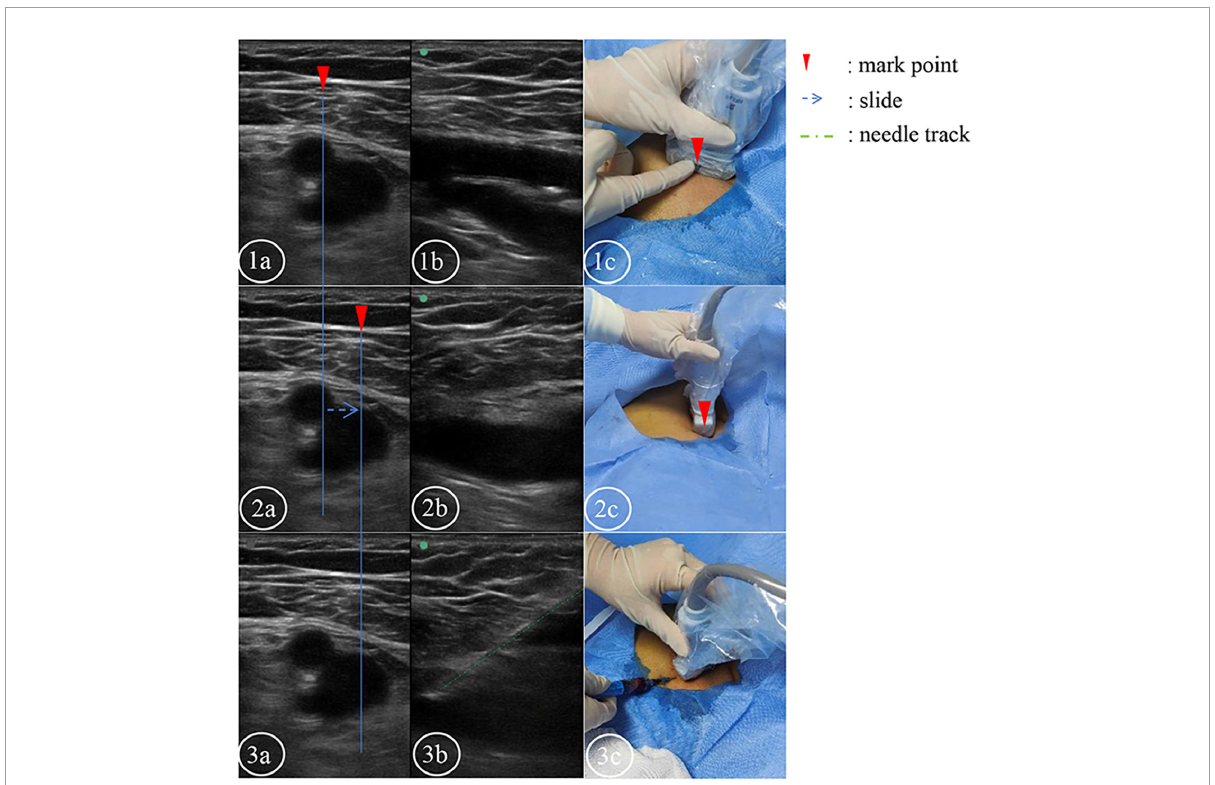
FIGURE1 The short and long axis double screens were used to control the puncture plane. (1–3a) Short-axis plane. (1–3b) Long axis plane. The corresponding body surface real-time ultrasound probe in picture (1c ). The corresponding body surface real-time ultrasound probe in picture (2c) . (3b) Plane of venipuncture. The green line indicates the needle trajectory. (3c) Real-time ultrasound probe on the body surface at the time of